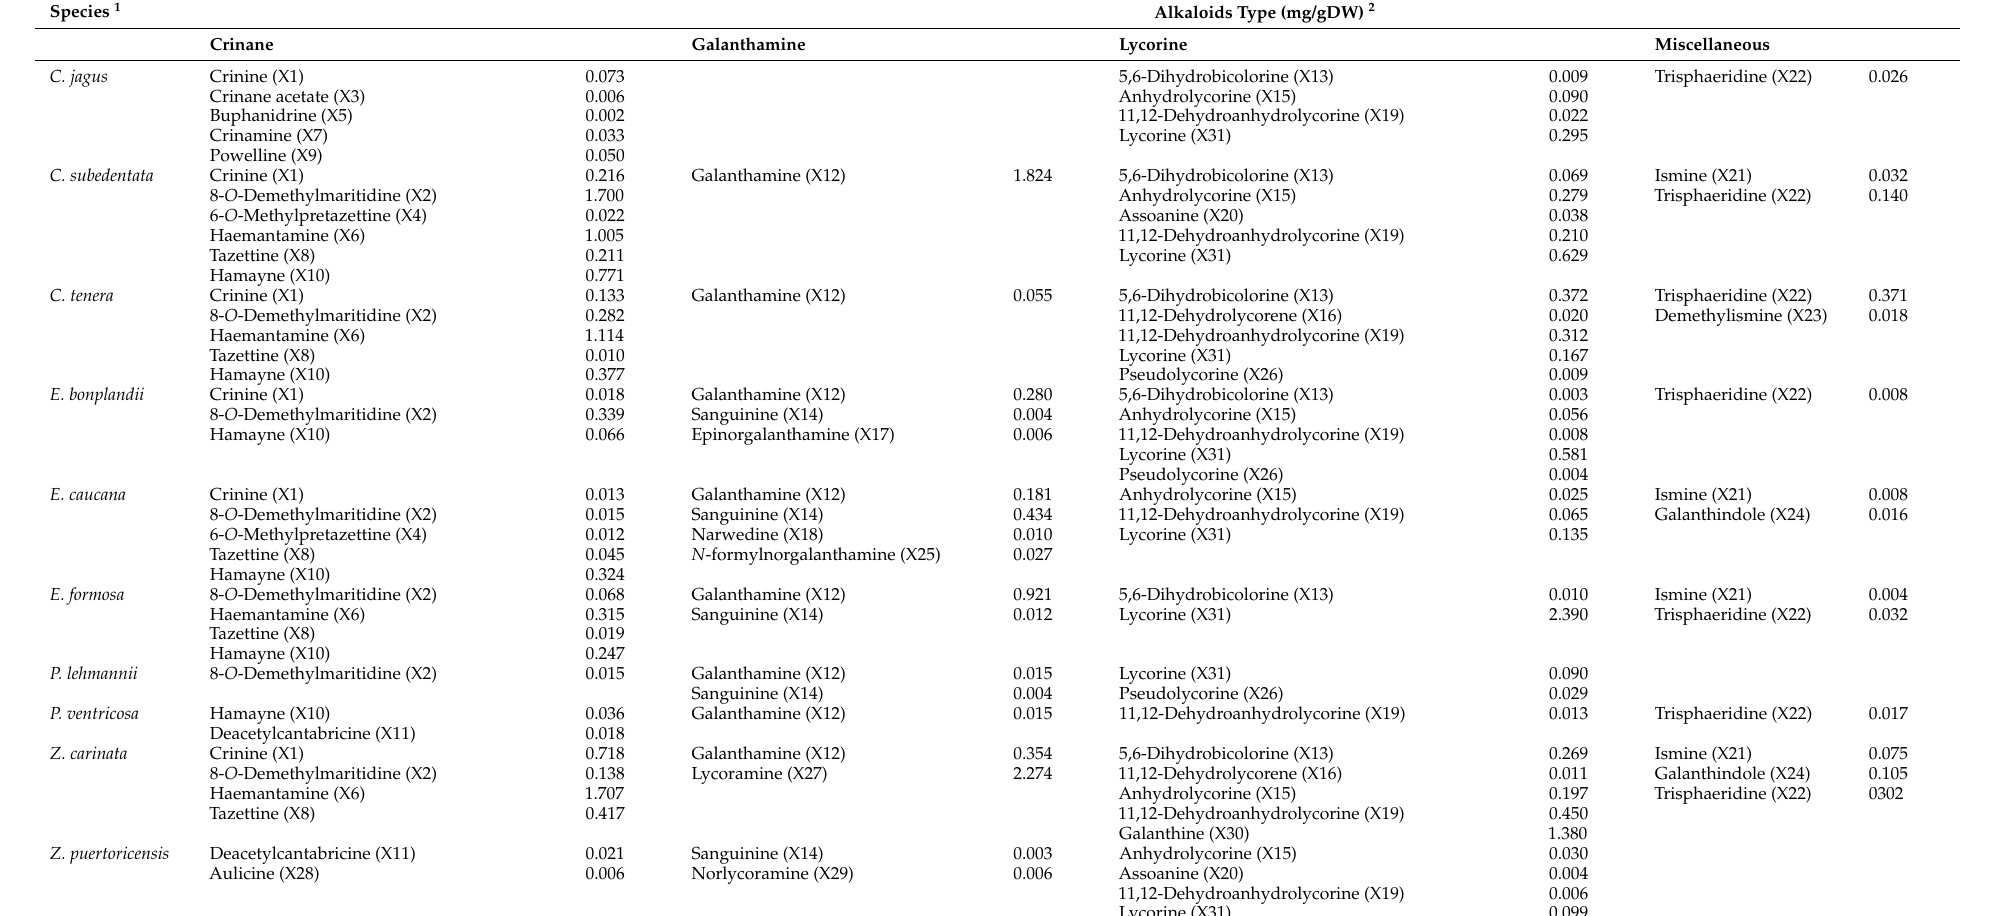
Table 3. Alkaloid profile of alkaloid fractions from Amaryllidaceae